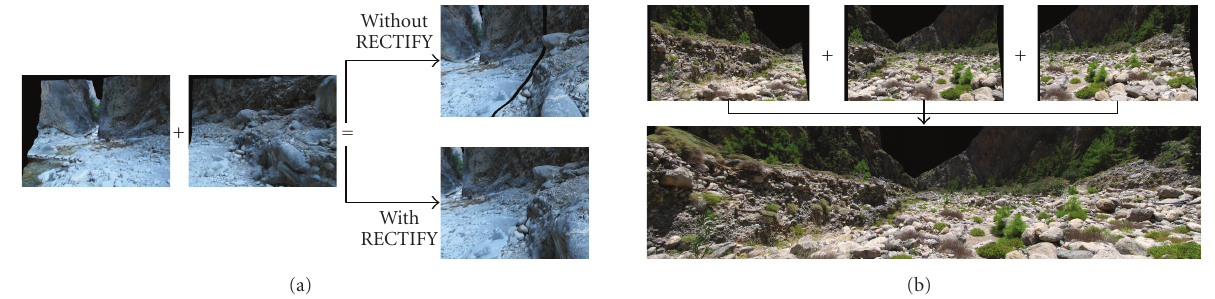
Figure 10: On (a) we show a portion of a 3D-mosaic constructed by combining two local models. We show the result both when no geometric rectification is applied to the local models and also when we do apply a geometric rectification. In the former case, notice the geometric inconsistency at the boundary between the two local models. On (b) we show another 3D-mosaic that has been constructed by combining three local models.